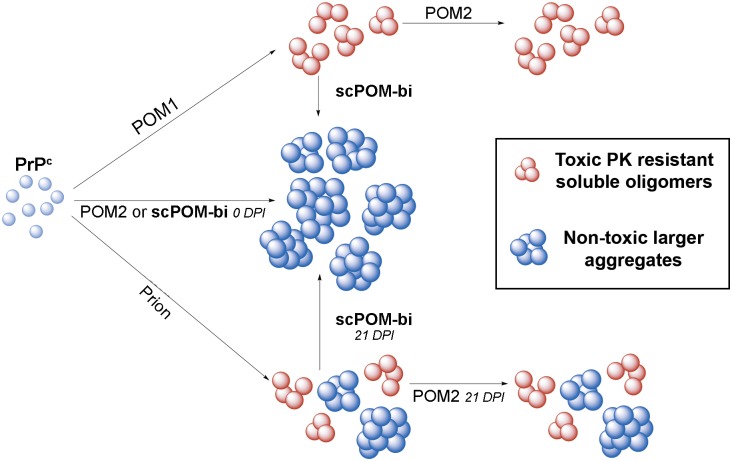
The bispeficic antibody scPOM-bi prevents the formation of soluble PrP oligomers and protects from prion neurotoxicity even when administered late after infection.Addition of POM1 antibody (top), but not POM2 or scPOM-bi, to PrPC generates soluble, pK resistant PrP oligomers (red) whose presence correlates with toxicity (top); subsequent addition of the neuroprotective scPOM-bi, but not POM2, eliminates them in favor of larger, non-toxic aggregates (blue). Small soluble oligomers might also be responsible for prion induced toxicity (bottom) similarly to other amyloidosis. scPOM-bi might be able to eliminate them just as it does with the POM1-induced oligomers whereas POM2 might not, which would explain why only the bispecific is neuroprotective even at late administration (21 days post infection, dpi).